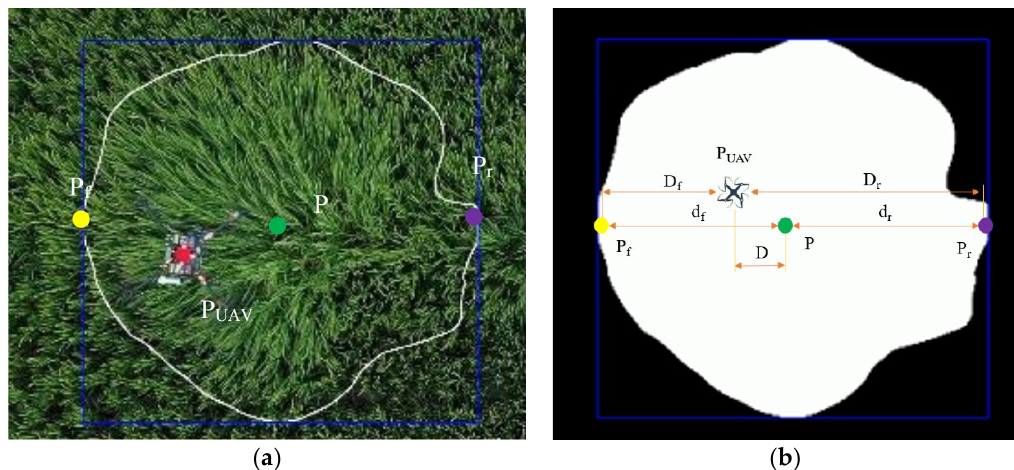
Figure 5. Wind-vortex parameters. ( a ) Original image of the wind vortex. ( b ) Binary image of the wind vortex. Note: The binary image ( b ) of the wind vortex is obtained by identifying the original wind-vortex image ( a ). The white outline in image ( a ) is the wind-vortex boundary, P is the wind-vortex centroid, PUAV is the center of the UAV, and D is the distance between the UAV and the centroid of the wind vortex. P f and P r are the front and rear extreme points of the wind vortex, respectively, D f and D r are the distances between the front and rear extreme points and the UAV, respectively, and d f and d r are the distance between the front and rear extreme points and the centroid of the wind vortex, respectively.